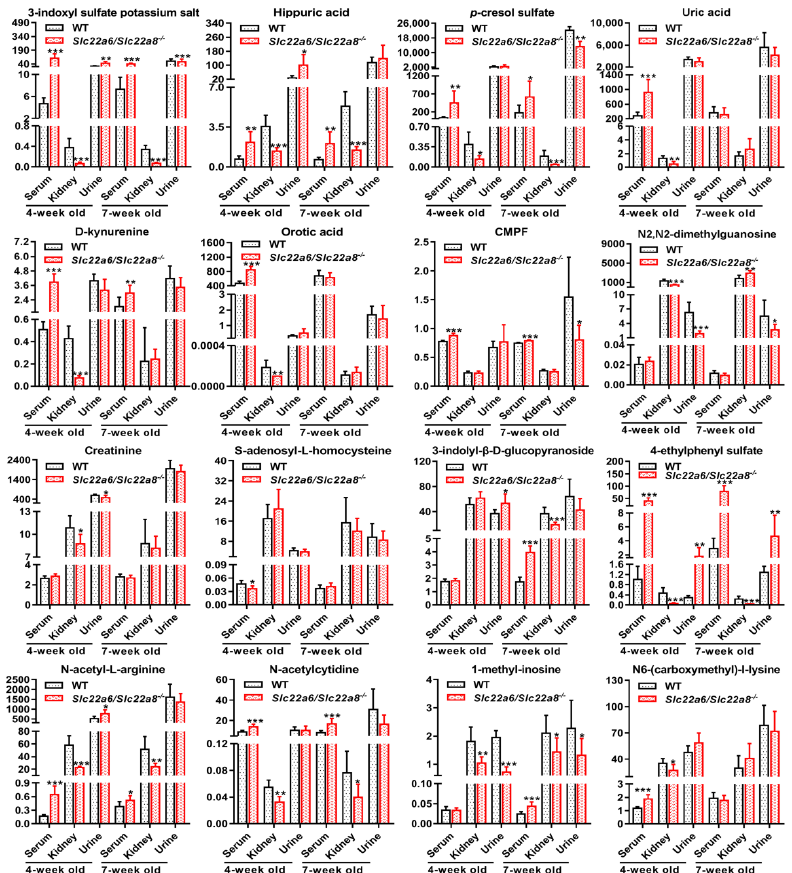
Figure 4. Effects of Slc22a6 / Slc22a8 double-knockout on the endogenous UTs (3-indoxyl sulfate potassium salt, hippuric acid, p -cresol sulfate, uric acid, D-kynurenine, orotic acid, CMPF, N2,N2-dimethylguanosine, creatinine, S-adenosyl- L -homocysteine, 4-ethylphenyl sulfate, 3-indolyl- β - D -glucopyranoside, N-acetyl- L -arginine, N-acetylcytidine, 1-methyl-inosine, N6-(carboxymethyl)-l-lysine) in 4W and 7W WT and KO rats. Plasma, urine concentration and kidney uptake ratio of UTs in 4W and 7W WT and KO rats. The unit of the plasma and urine concentration of UTs is ug/mL and the renal uptake ratio is ml/g. Data are presented as mean ± SD (n = 7). *, p < 0.05; **, p < 0.01; ***, p < 0.001 compared with WT rats.